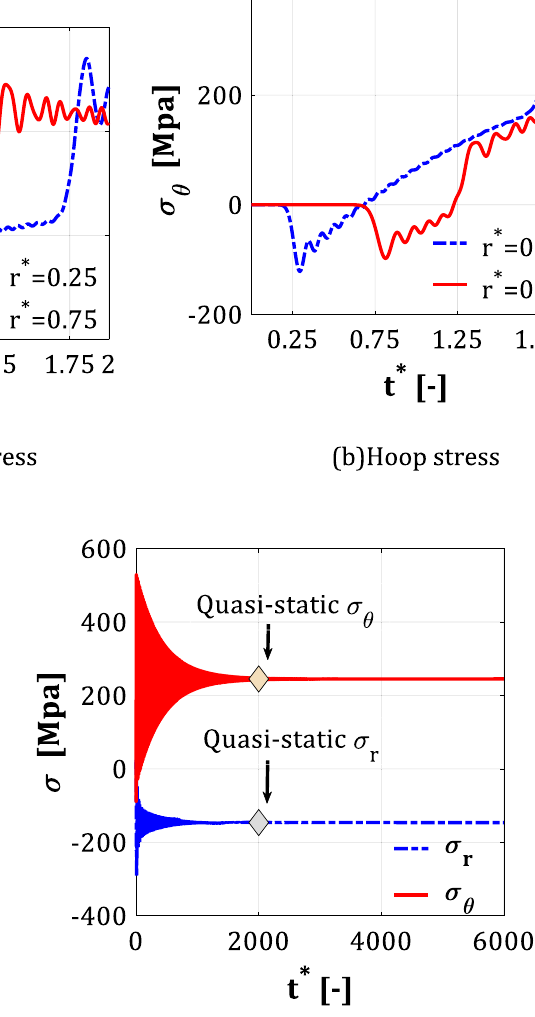
Fig. 4 Stresses-time history at specific non-dimensional radial positions